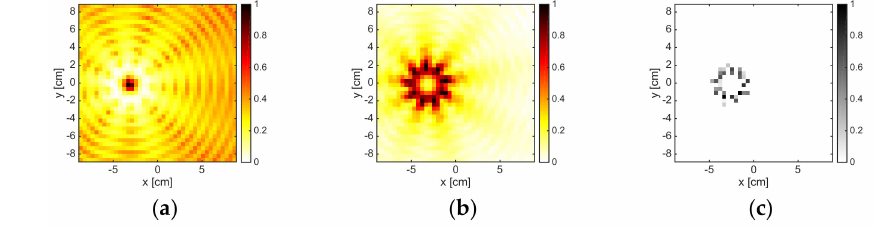
Figure4. TheDielTMtargetat12GHz. Fromlefttoright: LSM,OSM,andB-ISindicators. Thedimension of the data matrix was 72 ×